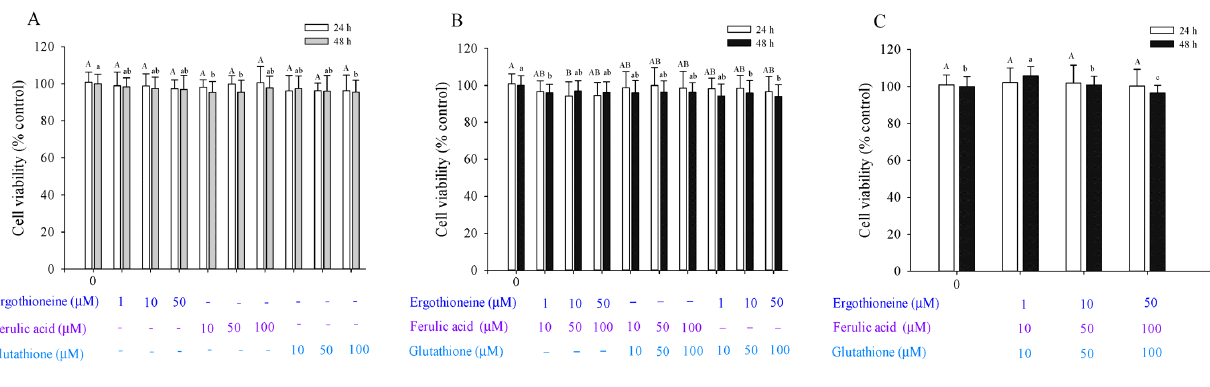
Figure 2. Viability of Hs68 cells after 24 h and 48 h in the presence of a single antioxidant ( A ), combination of two antioxidants ( B ), and combination of three antioxidants ( C ), namely ergothioneine, ferulic acid, and glutathione. Each value is expressed as the mean ± SD ( n ≥ 3). Different letters indicate significant differences among treatments ( p < 0.05).